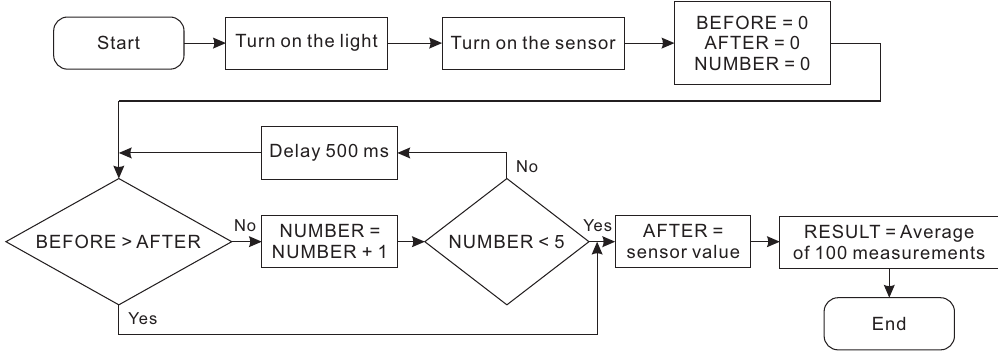
Figure 7. Algorithm of data acquisition from the light